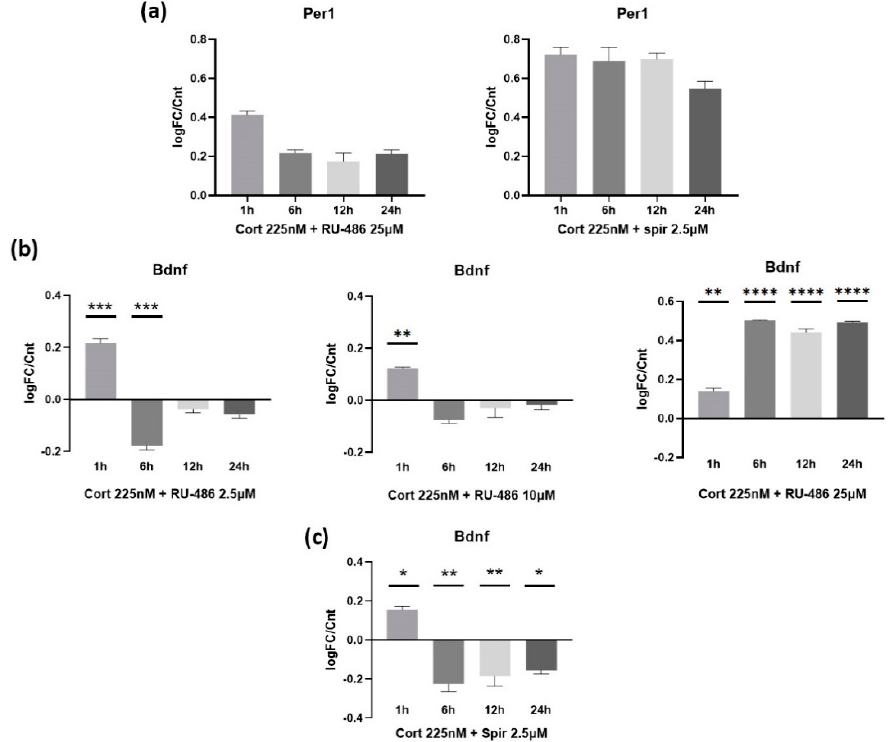
Figure 2. ( a ) The mRNA expression levels of Per1 gene were measured after the administration of RU-486 25 μ M (left) and spironolactone 2.5 μ M (right) along with Cort (225 nM). RU-486 markedly inhibited the expression of Per1 , while spironolactone had no effect whatsoever, as expected. ( b ) RU-486 was able to diminish the late inhibitory effect of Cort administration in a dose-dependent manner, with higher concentrations (25 μ M) even allowing for complete reversion of the effect, leading to Bdnf overexpression for up to at least 24 h. ( c ) The effects of spironolactone (2.5 μ M) on Bdnf expression in astrocytes after Cort administration (225 nM) were evaluated on astrocytes at 4 timepoints (1 h, 6 h, 12 h, 24 h). Spironolactone did not demonstrate any significant effect on neither the early nor the late response mediated by the Cort administration. n = 3 for each experiment. * p < 0.05, ** p < 0.01, *** p < 0.001, **** p < 0.0001; one-way ANOVA. Data are mean ± S.E.M.